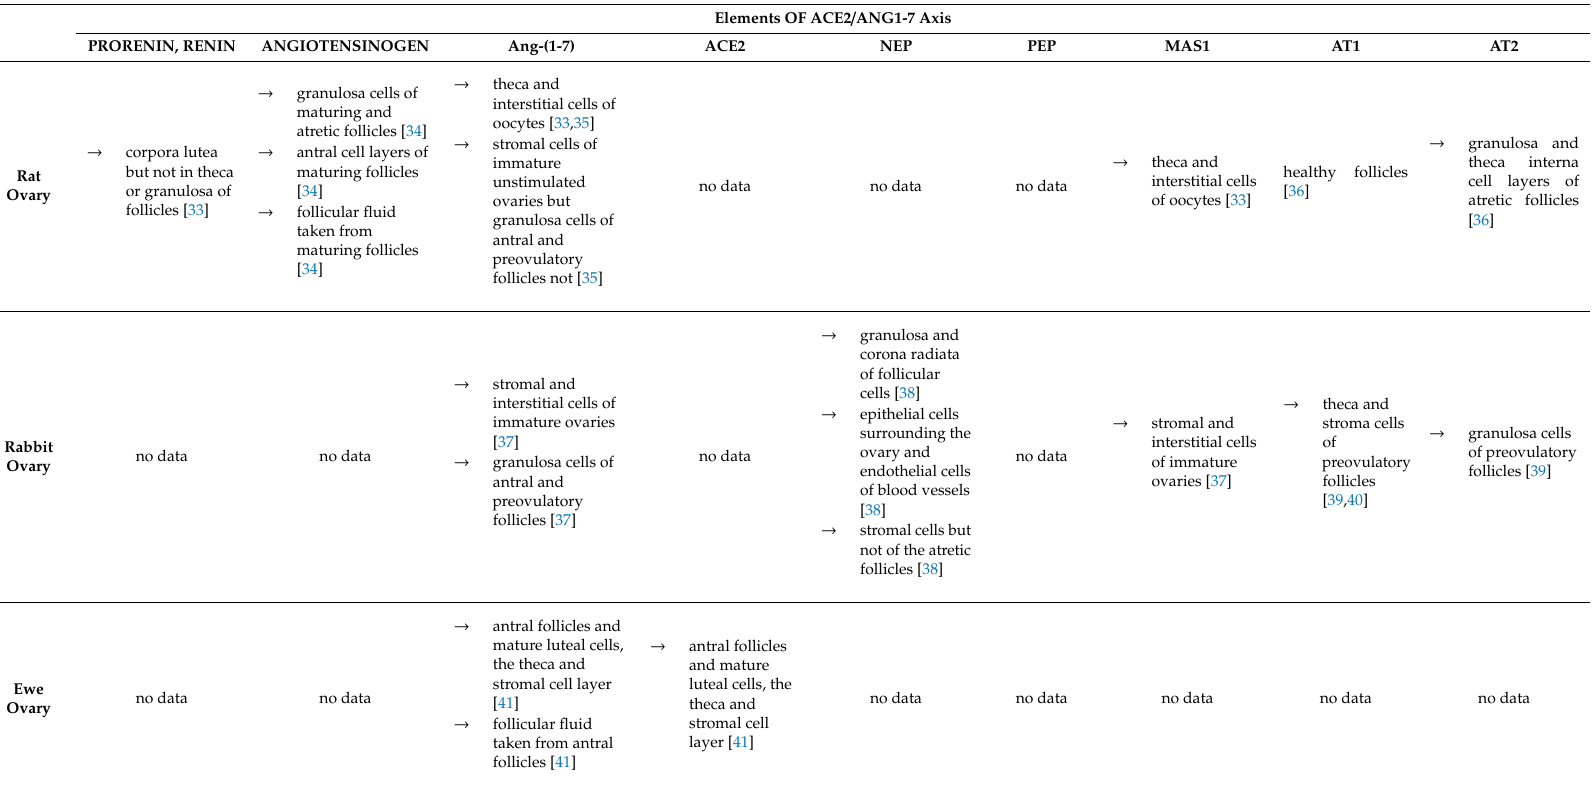
Table 1. The confirmed location of individual members of ACE2 / Ang-(1-7) axis in the mammalian ovary (Ang-(1-7)—angiotensin-(1-7); ACE2—angiotensin-converting enzyme 2; NEP—neutral endopeptidase; PEP—prolyl endopeptidase; MAS1—MAS receptor; AT1—AT1 receptor; AT2—AT2